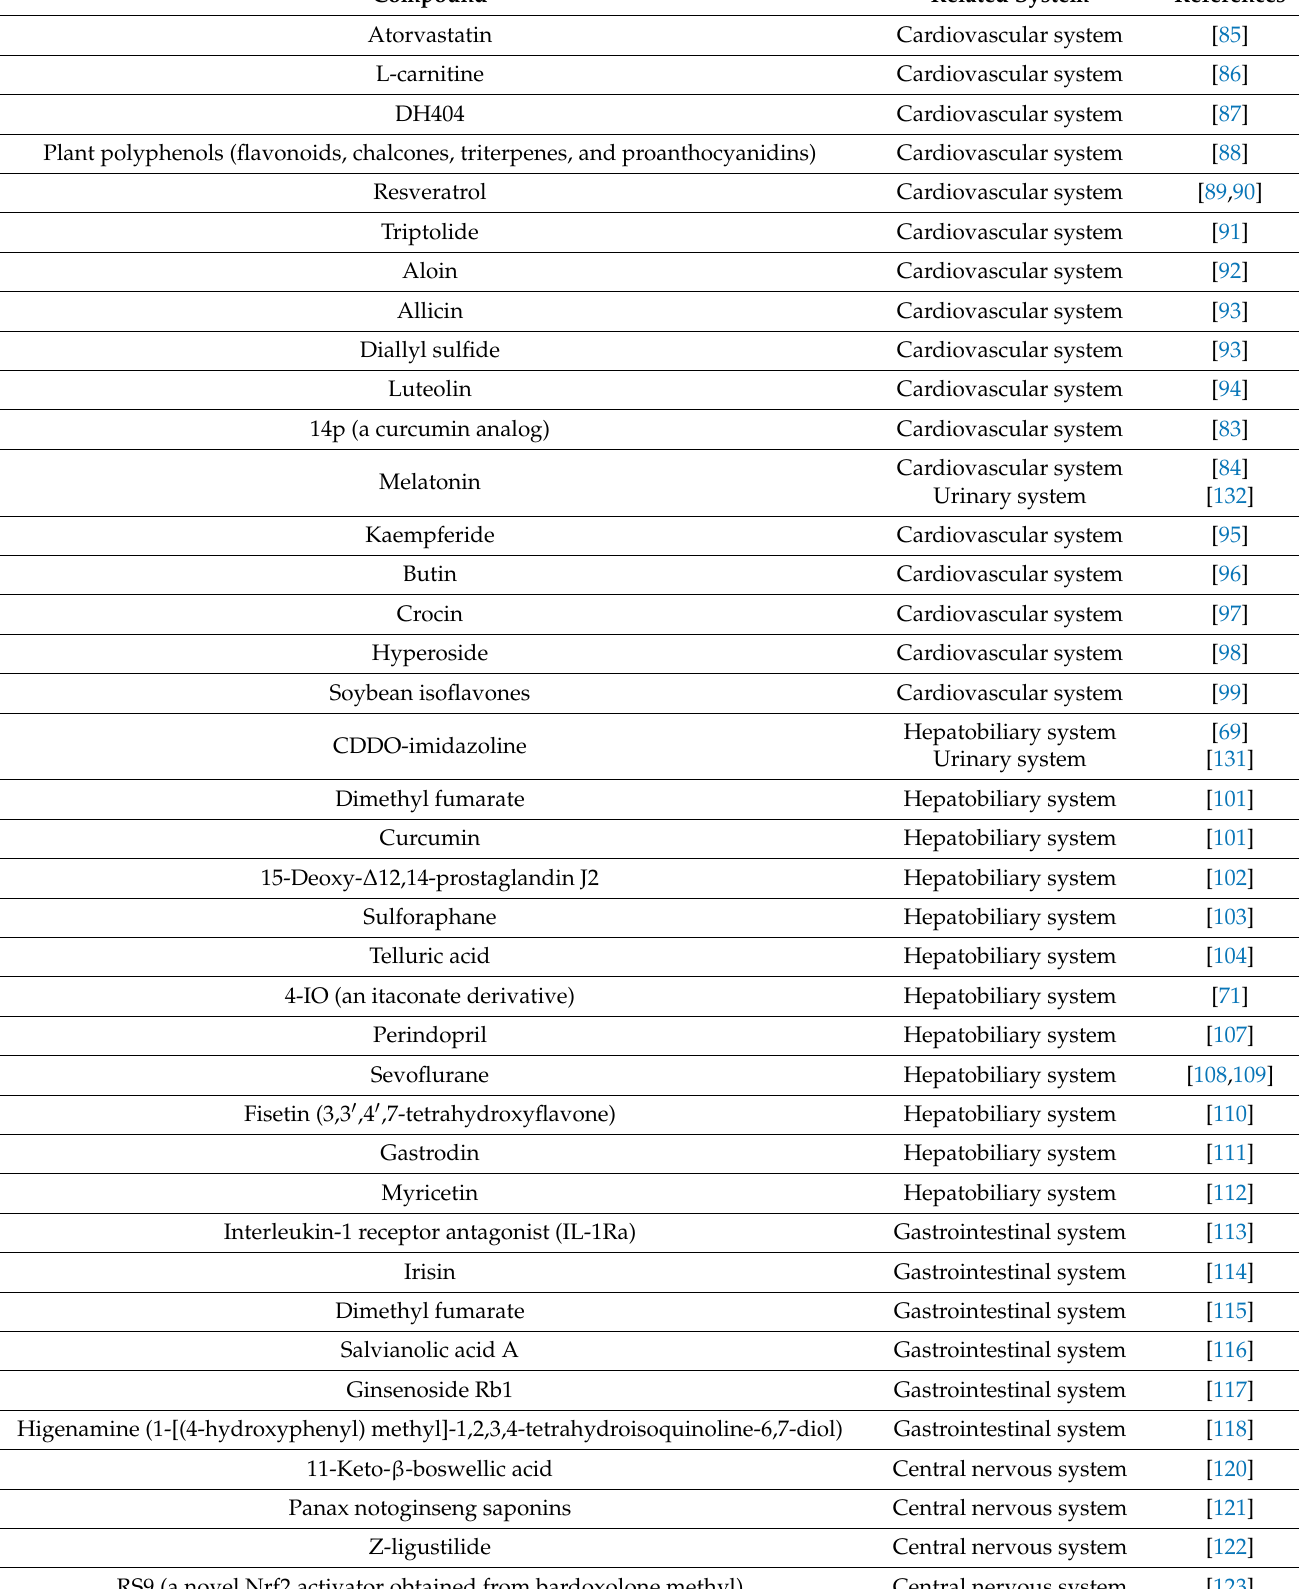
Table 1. An overview of potential compounds with a protective effect on I/R injury by inducing the Nrf2 pathway.